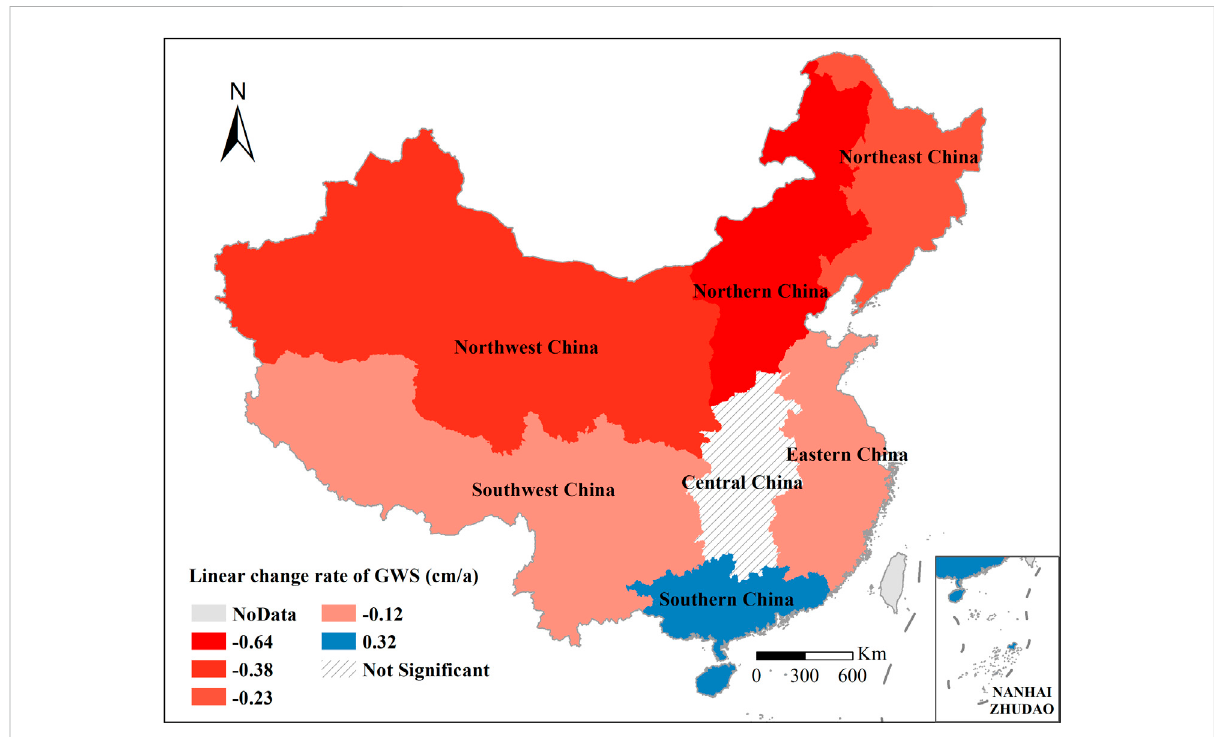
FIGURE 5 Linear rates of change in GWS in the seven regions of China from 2002 to